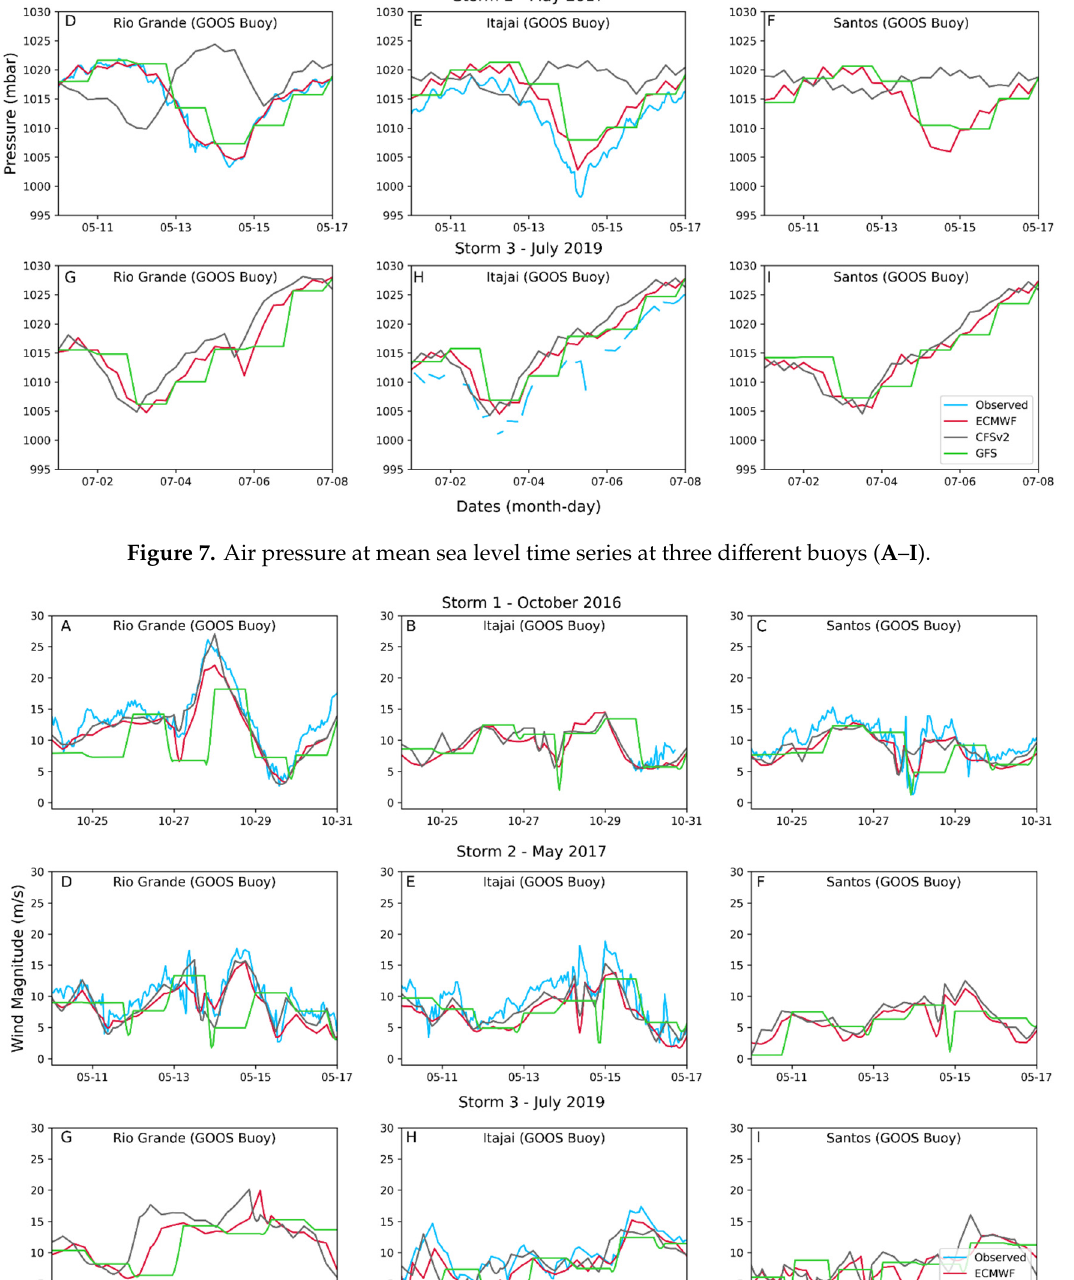
Figure 8. ( A – I ) Winds at 10 m above the sea surface time series at three different buoys.